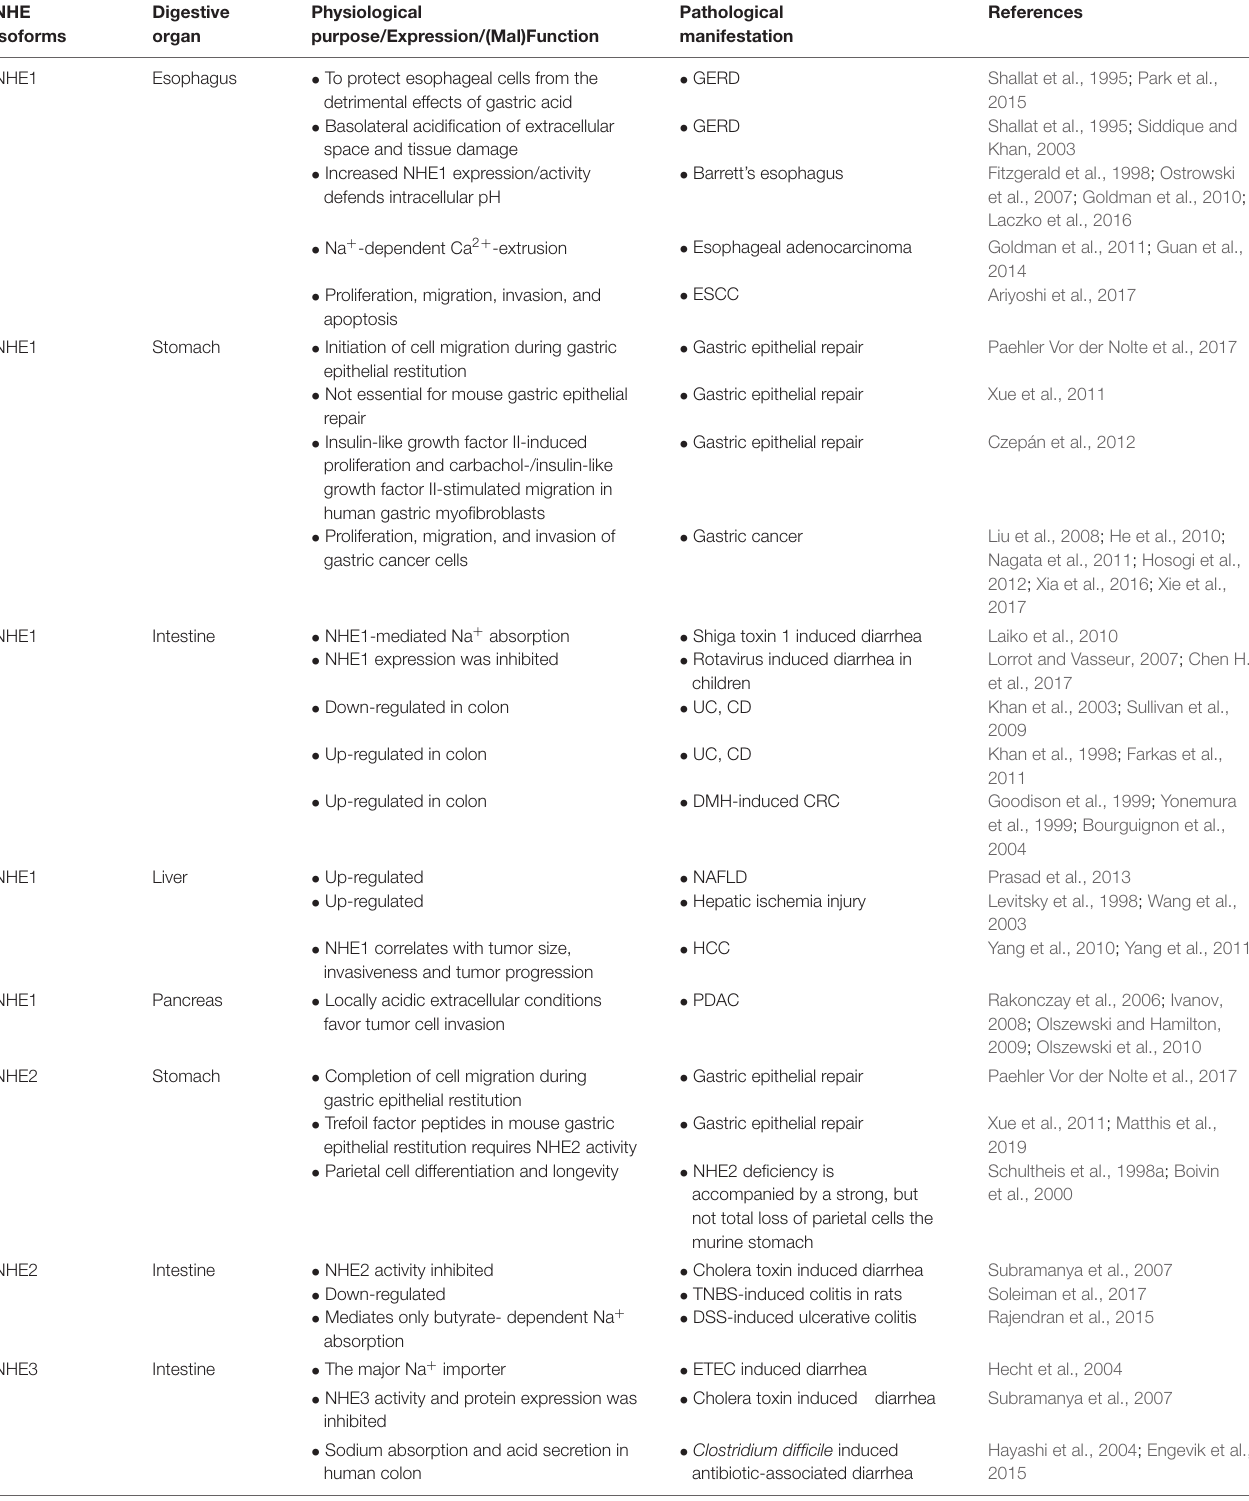
TABLE 1 | NHE isoforms, their locations, (patho)physiological impact, and relevant references. NHE Digestive isoforms